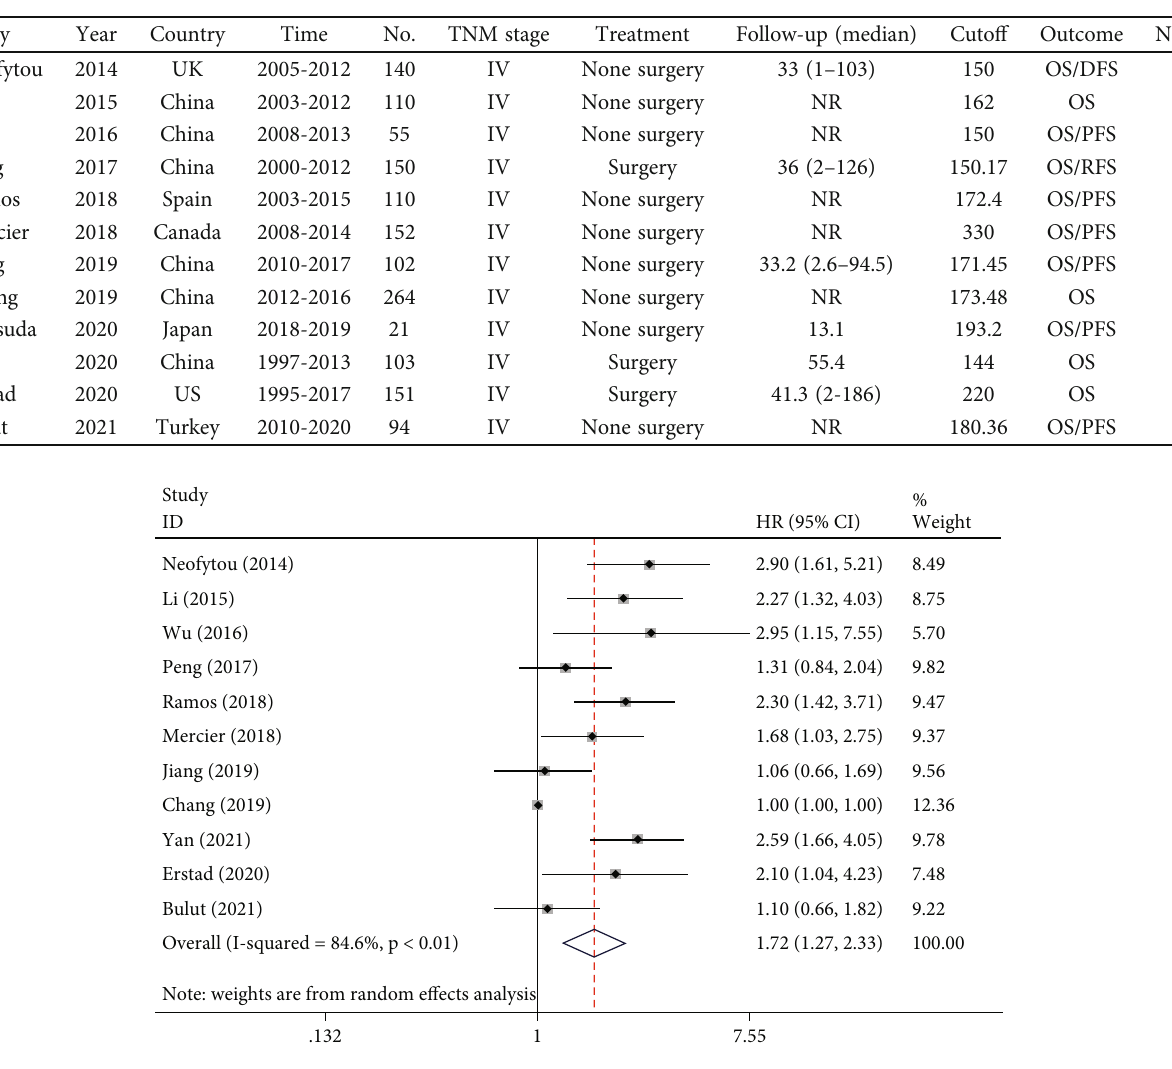
Table 1: Characteristics of studies included in the meta-analysis.